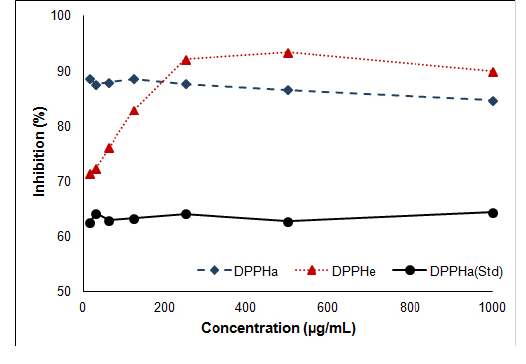
Fig. 4. Total antioxidant capacity of aqueous and ethanol extracts of D. sarmentosa